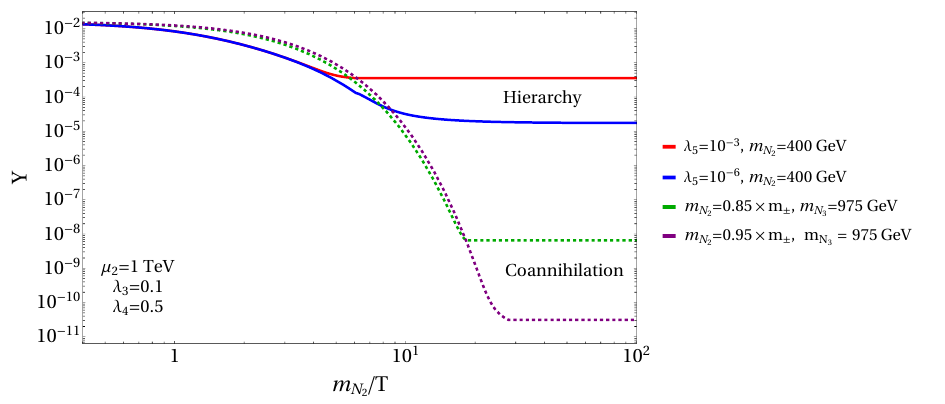
Figure 2. Evolution of the total N 2 yield for di(cid:11)erent values of (cid:21) 5 in a scenario with vastly di(cid:11)erent scalar and N 2 masses (red and blue curve) as well as in the case when the masses are similar (green and purple dashed curve). In the latter case, due to larger interaction strength, N 2 remains in thermal equilibrium longer, yielding orders of magnitude smaller N 2 abundance with respect to the former